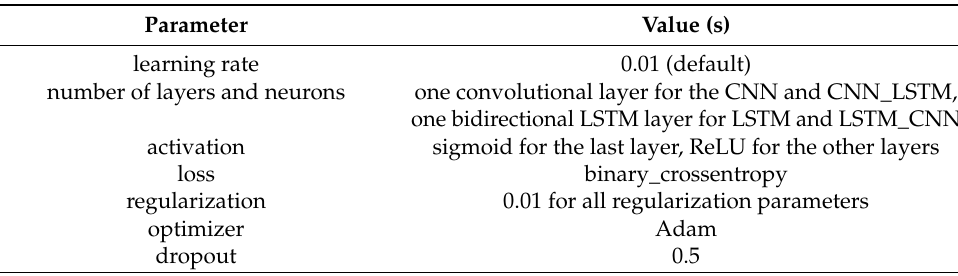
Table 7. NN parameters for the individual models. Parameter Value (s) learning rate 0.01 (default) number of layers and neurons one convolutional layer for the CNN and CNN_LSTM, one bidirectional LSTM layer for LSTM and LSTM_CNN activation sigmoid for the last layer, ReLU for the other layers loss binary_crossentropy regularization 0.5